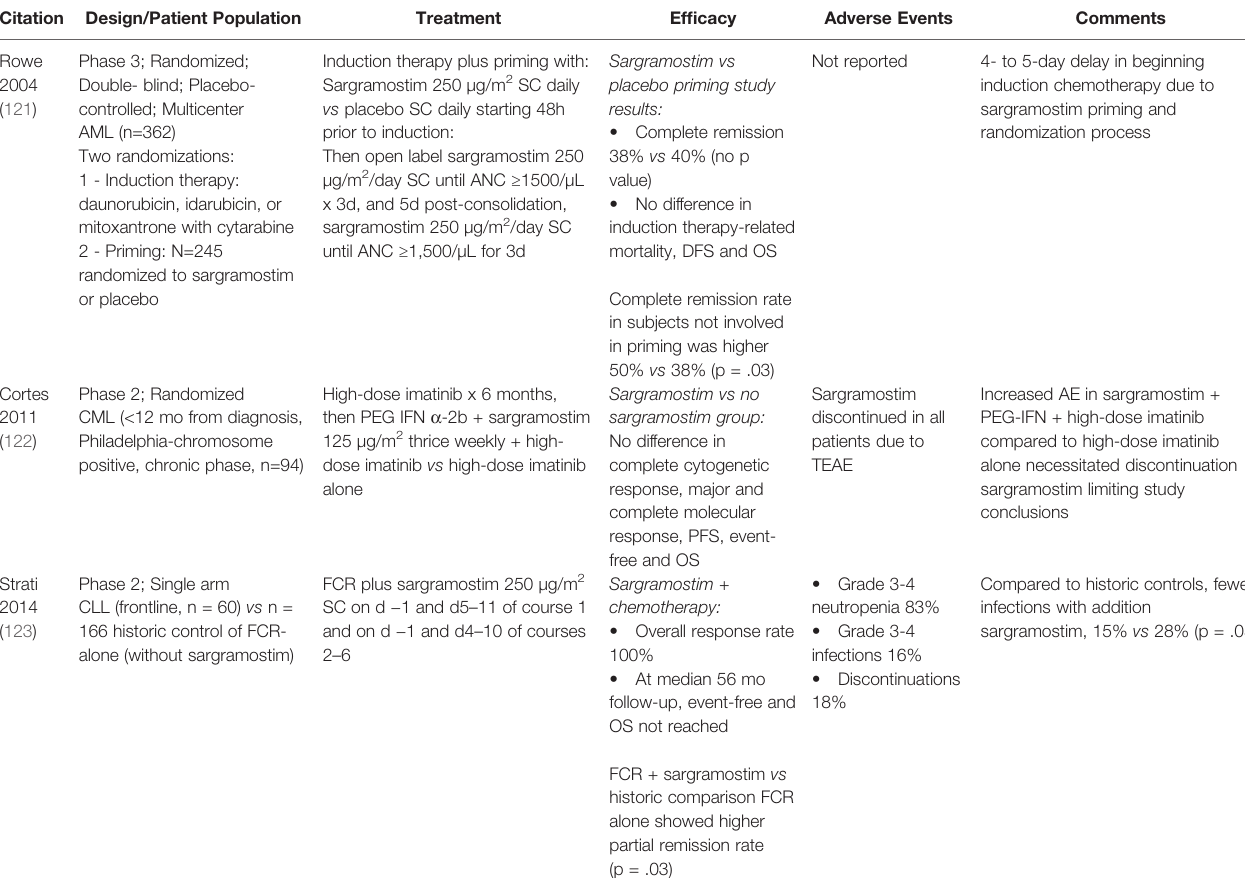
TABLE 5 | Clinical studies evaluating immune-enhancing effects of sargramostim in hematologic malignancies (AML, CML, CLL). Citation Design/Patient